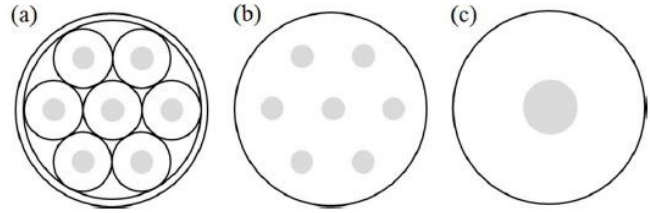
Figure 1. The typical examples of optical fibers for space division multiplexing (SDM) technology: ( a ) multi-element fiber; ( b ) multicore fiber; ( c ) multi-mode fiber [4].